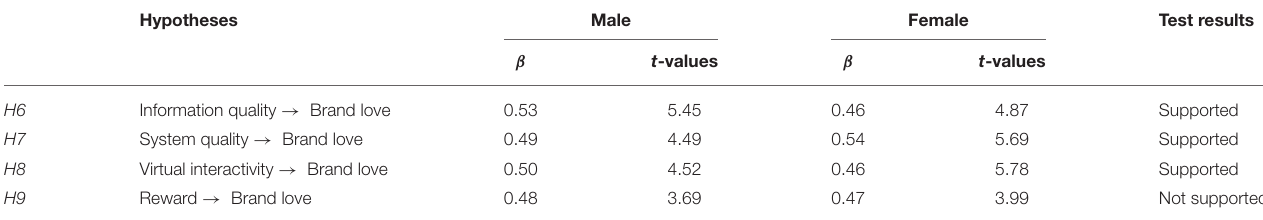
TABLE 5 | Hypotheses testing results across